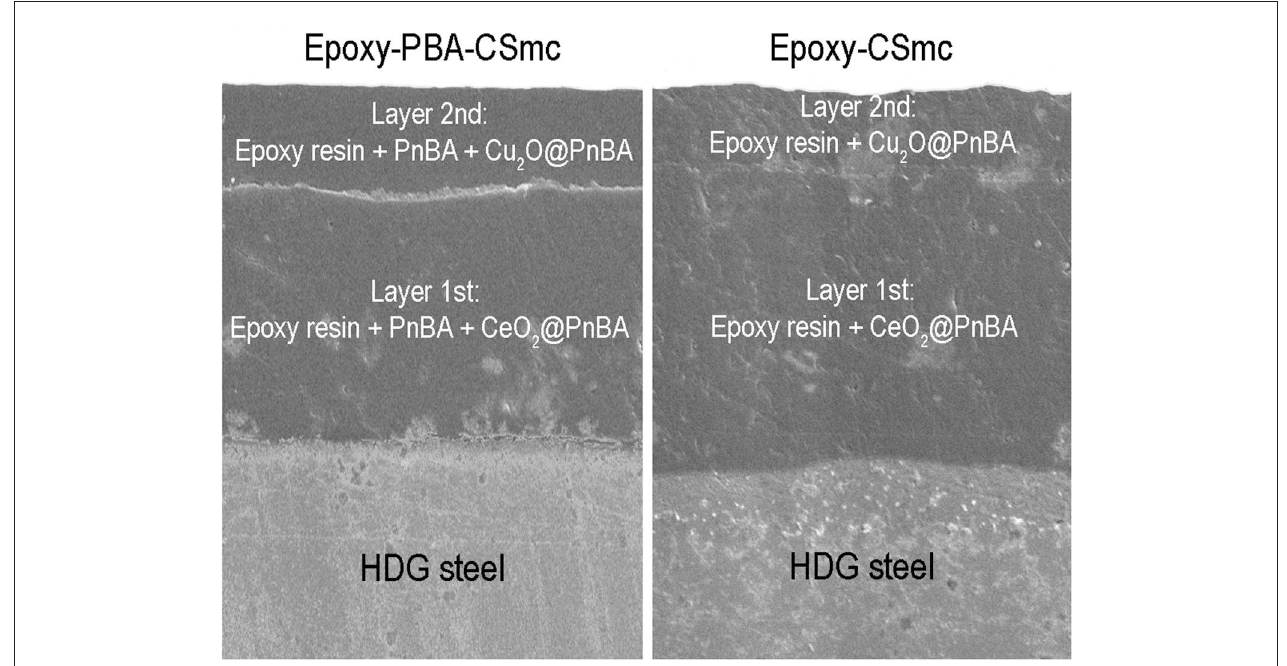
FIGURE 1 | Schematic representation of the produced two-layer coating systems.